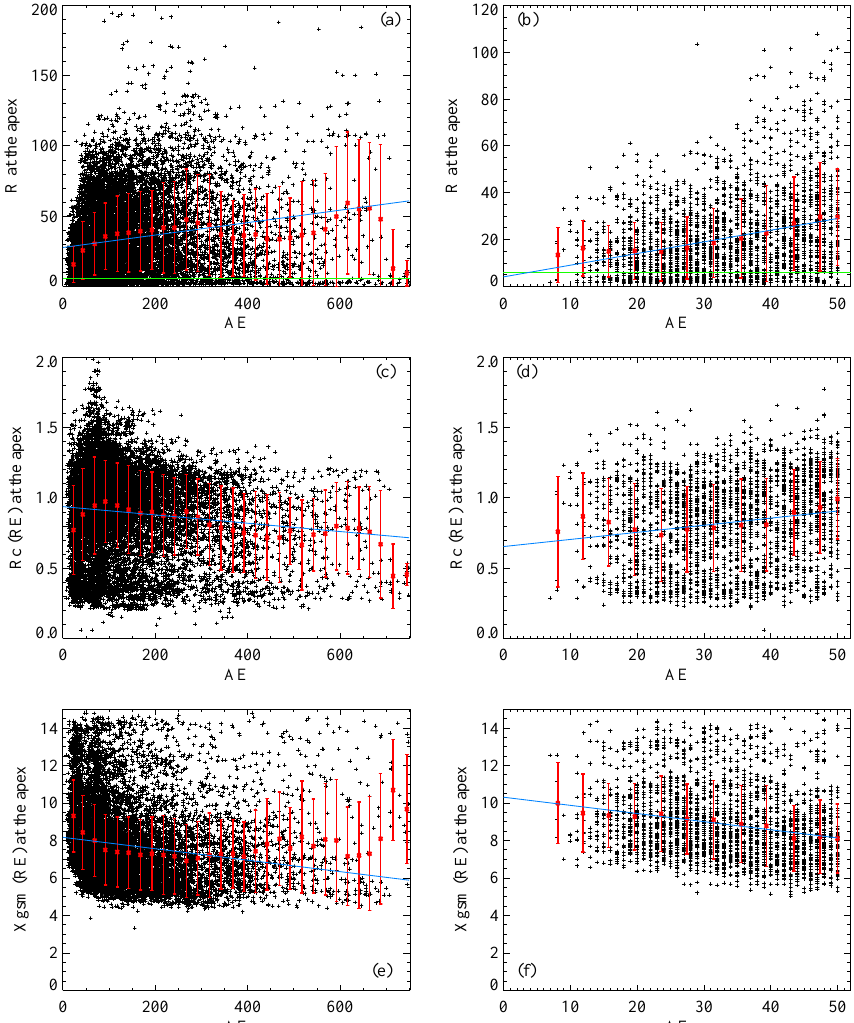
Fig. 3. Distribution of the R value (a, b) , the curvature radius R C (c, d) , and the distance X GSM (e, f) at the apex of the magnetic field line determined from MAX-SI12 using T01 as a function of the AE auroral activity index. The data base includes 17874 SI12 images collected in December 2000 and January 2001. The left plots (a, c, e) show all cases, and the right plots (b, d, f) AE smaller than 50. The red points (with standard deviation bars) represent the mean value over a fixed interval of AE, the green line is the expected value R = 6 at the maximum of the proton precipitation, and the blue line is the linear regression over the entire data